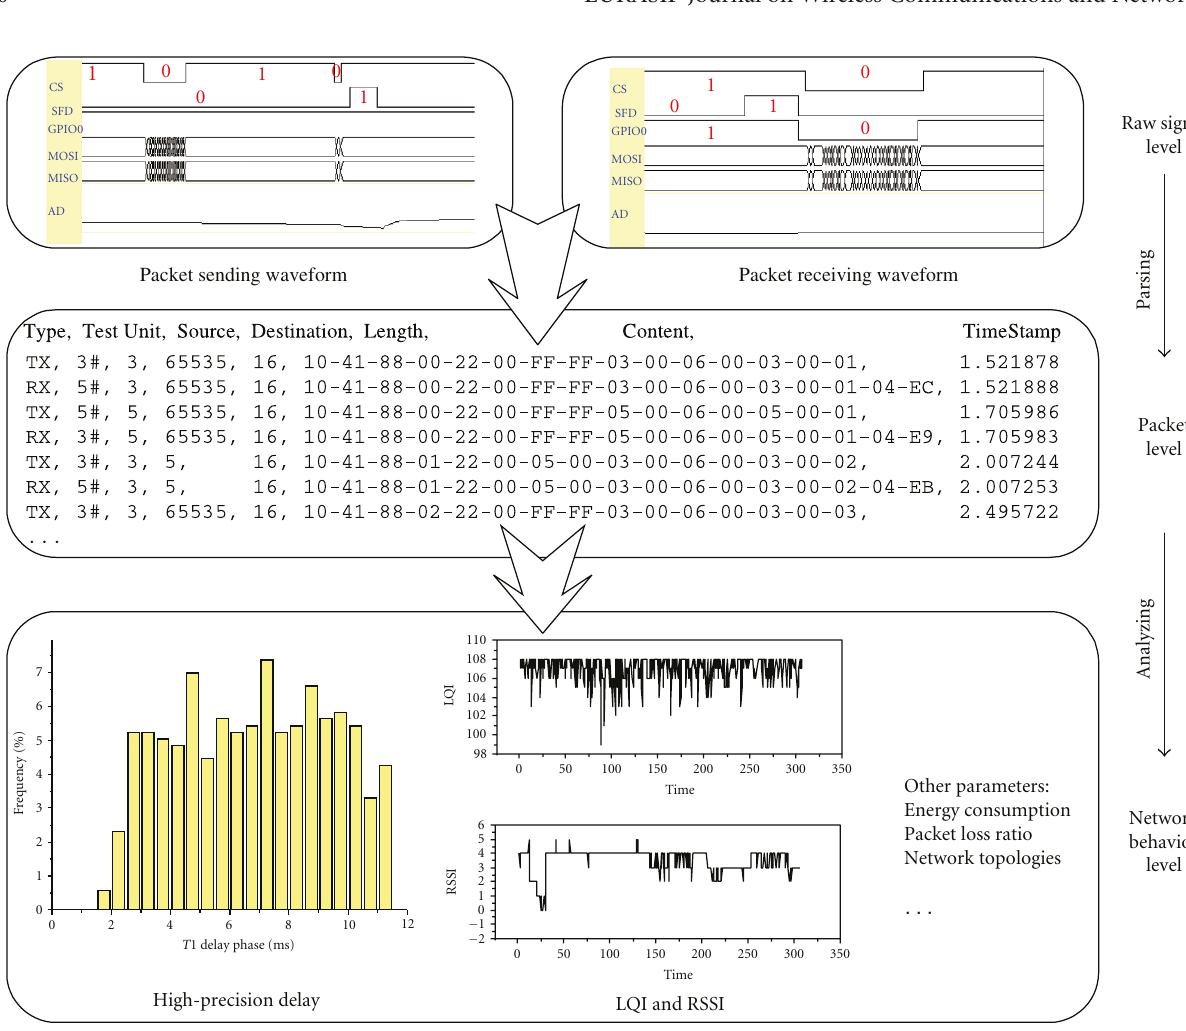
Figure 16: Feature levels of